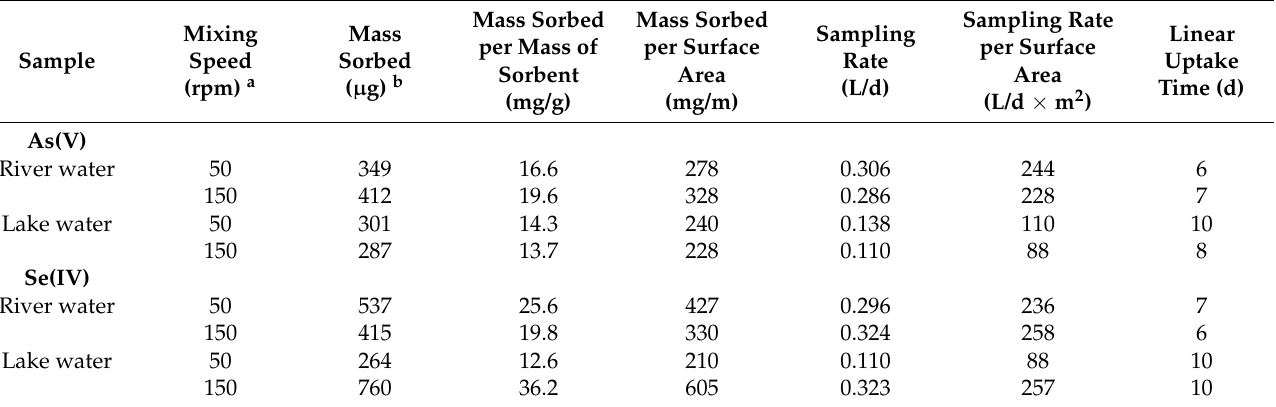
Table 1. Parameters of passive diffusion uptake of As(V) and Se(IV) from genuine water samples on MOR − 1@cotton fabric at the linear uptake phase.